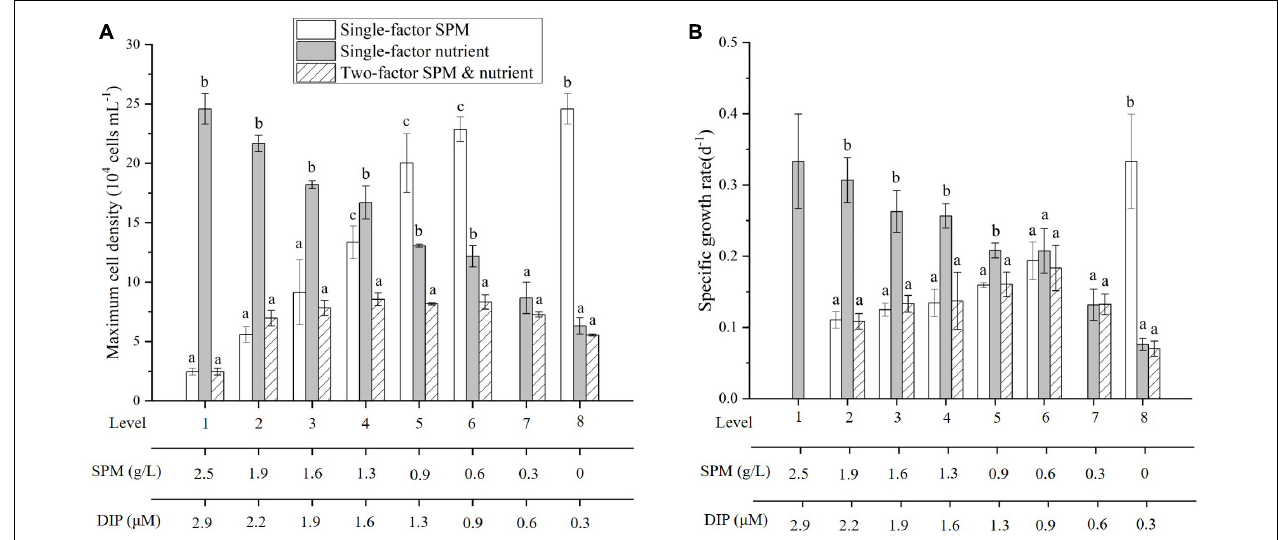
FIGURE 6 | Comparison of maximum cell density (A) and specific growth rate (B) of A. carterae in the single-factor and two-factor experiments. Different letters (a, b, c) indicate significant differences among treatments when compared to the two-factor experiment.